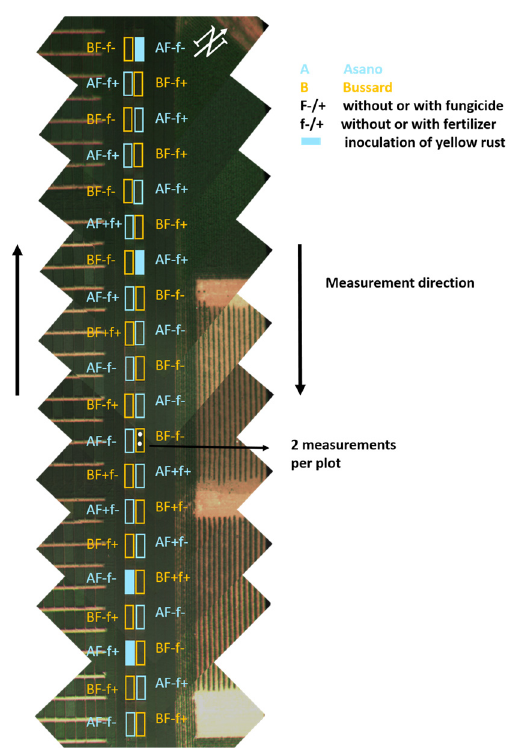
Figure 1. Field trial layout (RGB stitch from unmanned aerial vehicle (UAV) images) at the research station Campus Klein-Altendorf (Rheinbach, Germany) of winter wheat varieties Bussard and Asano in 2018, with treatment declaration and measurement strategy. The trial was designed in two long rows of plots to reduce the number of turns and keep continuous measurements.